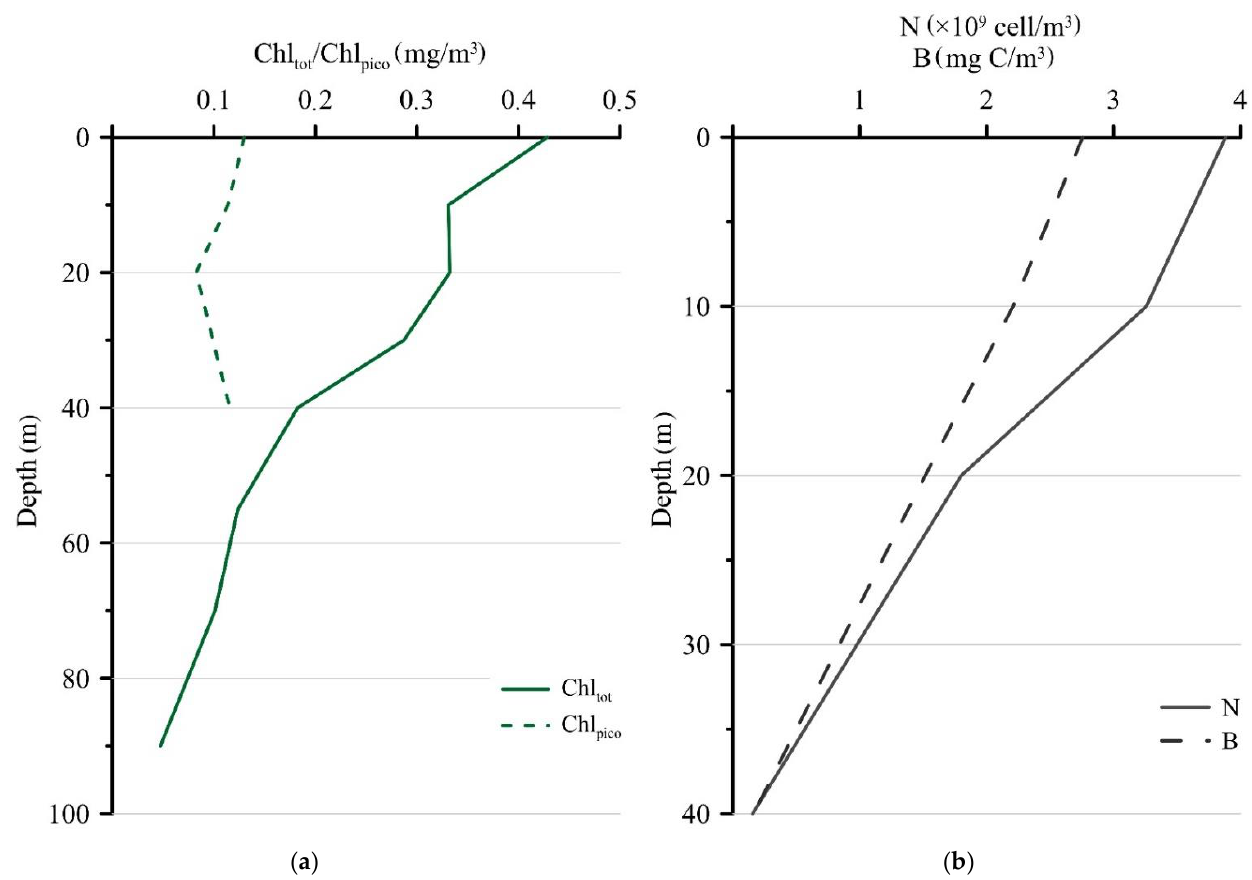
Figure 2. Annual course of air temperature and ice cover (based on data from http://www.aari.ru, accessed on 1 September 2021) in the area of the studied station 5976, the Kara Sea.